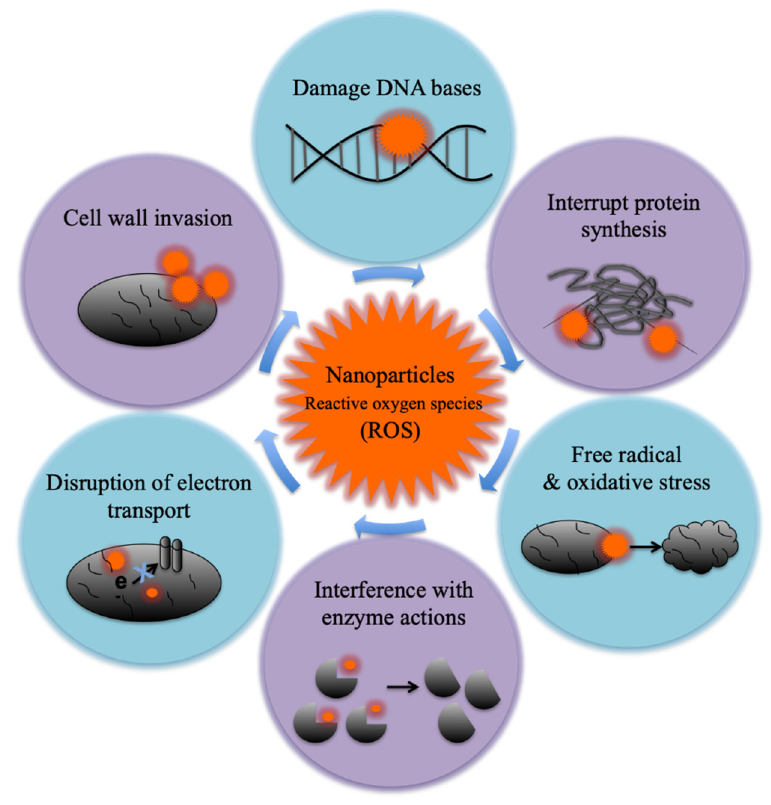
Figure 34. Mechanism of bactericidal effect of the nanoparticles.